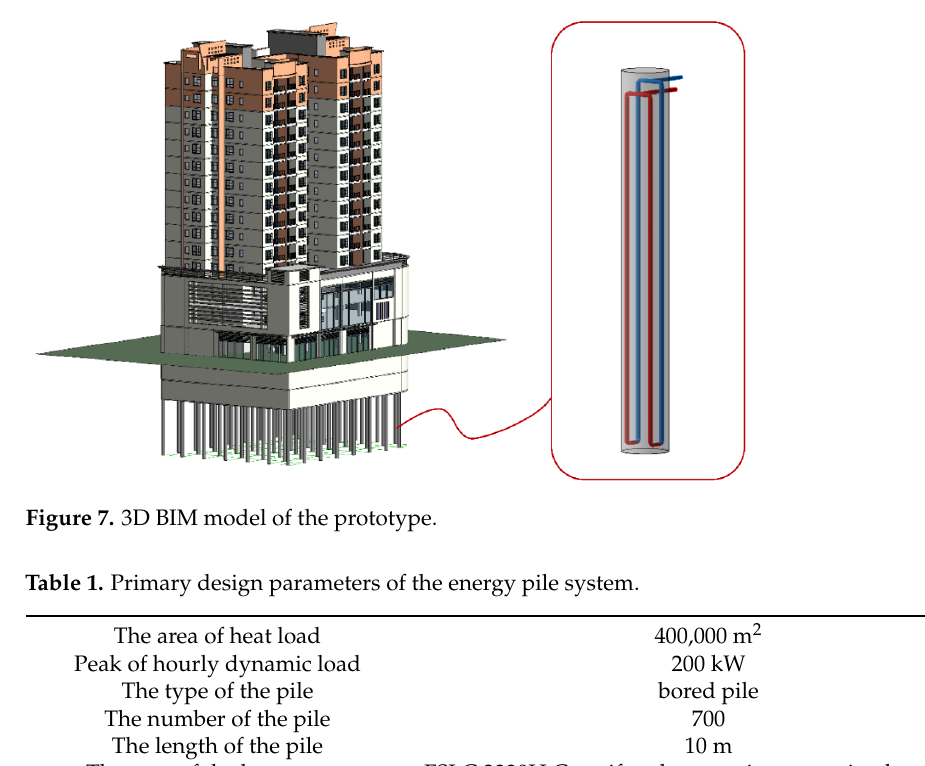
Table 2. Primary parameters of heat exchangers.